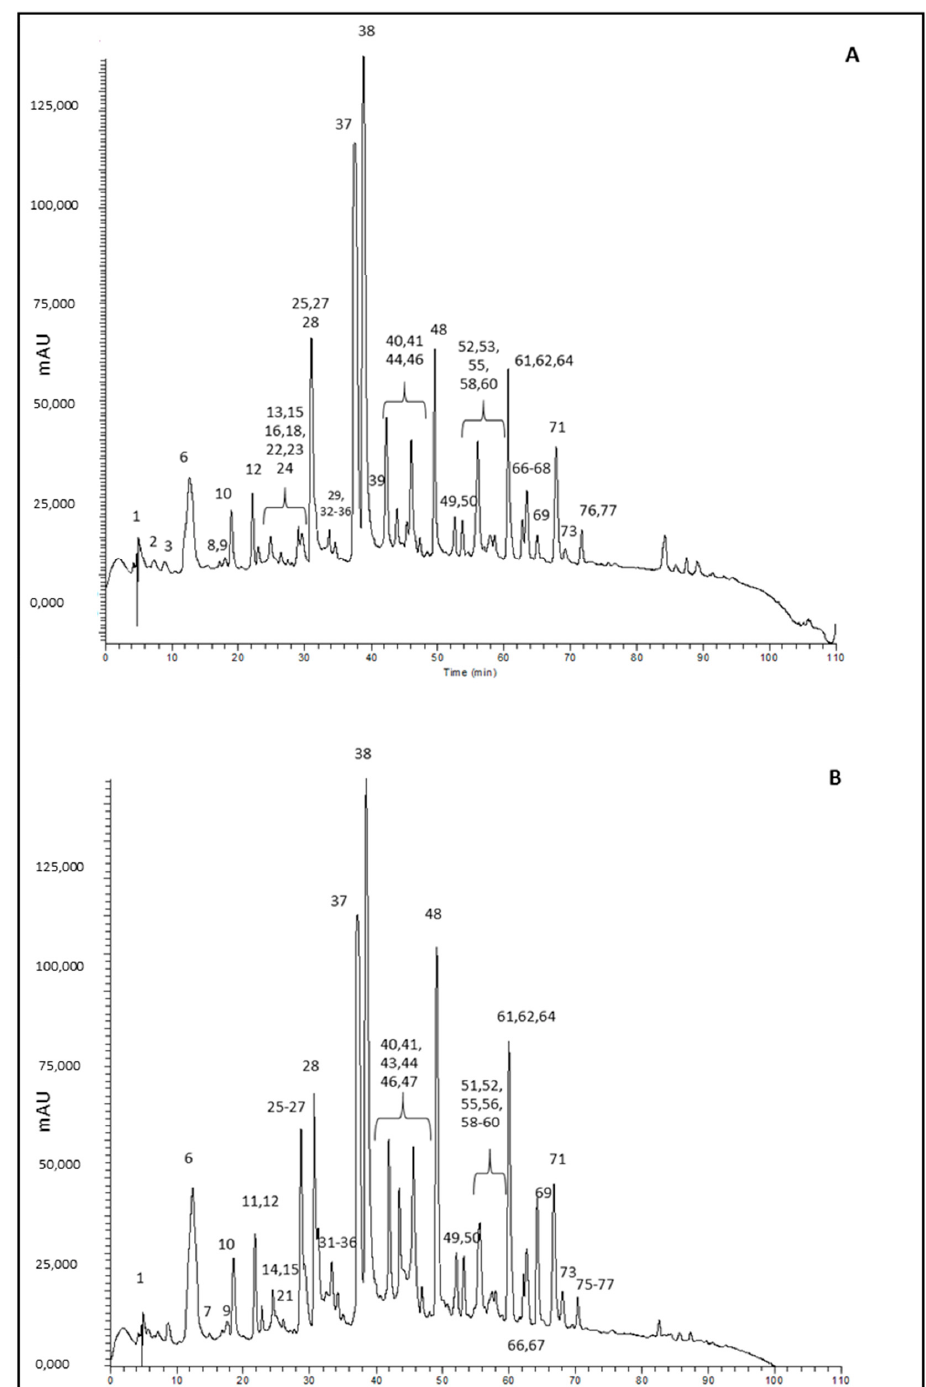
Figure 3. Chromatograms, acquired as total scan PDA, of ( A ) OTS3 and ( B ) GT1 tea extracts at 5 mg/mL. Caffeine and theobromine identified in peaks 12 and 37, respectively, are common xanthine alkaloids occurring in tea leaves [29]. Fare clic o toccare qui per immettere il testo.